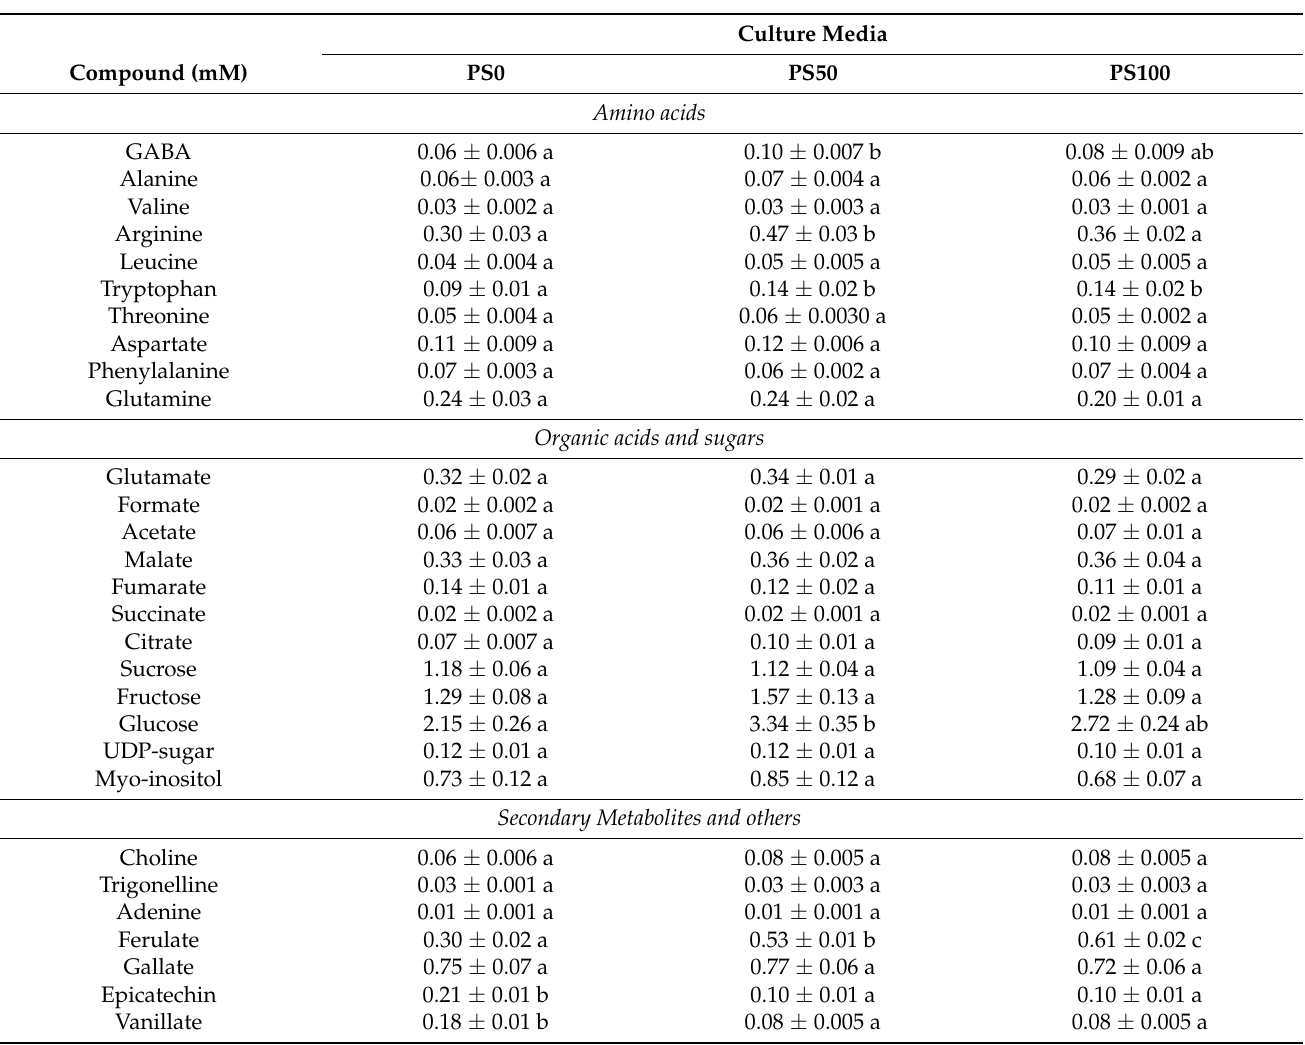
Table 3. Leave metabolomic analysis results by substrates. The results presented are the mean values ±